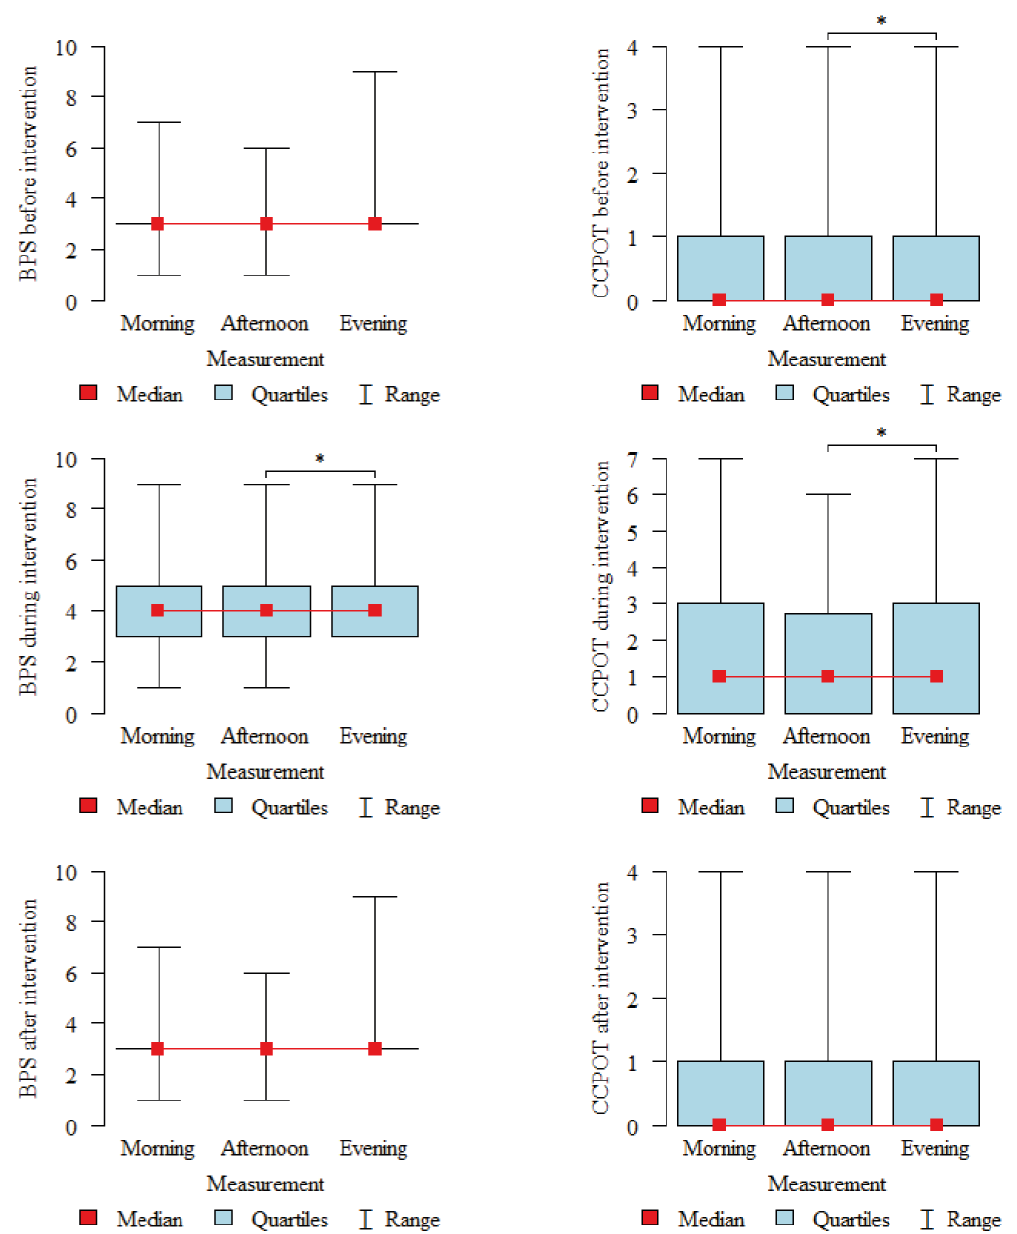
Figure 2. Mean BPS and CCPOT scores at different times of day (data from1005 measurements). * p